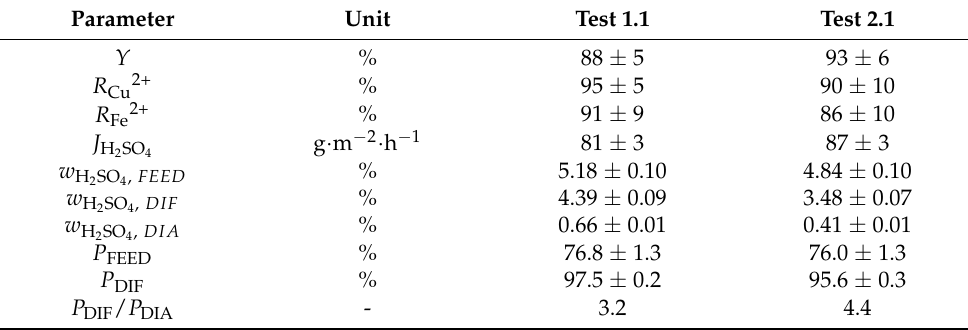
—flux of acid, 2 SO 4